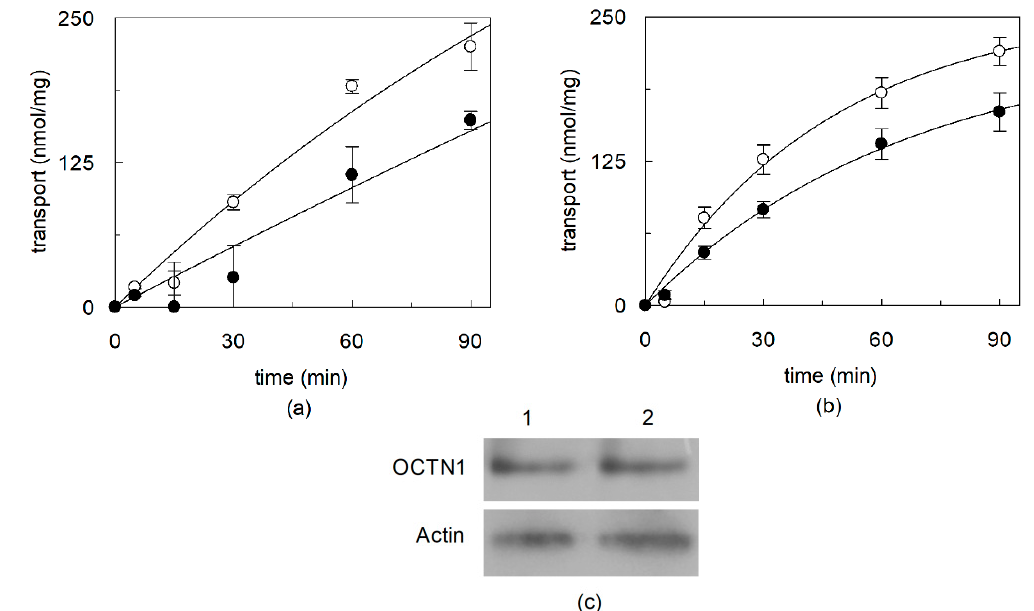
Figure 1. Effect of cholesterol removal on the native OCTN1. (a) HeLa cell protein extract or (b) HeLa cell sample was incubated in the absence ( ○ ) or in the presence of 10 mM M β CD ( ● ) and then the extracts obtained in the two different conditions ( a or b ) and corresponding respectively to 2.1 ± 0.04 ( a ) and 2.2 ± 0.07 µg protein ( b ) were reconstituted in liposomes as described in Section 4.4. Transport was started adding 0.1 mM [ 14 C]-TEA at time zero to proteoliposomes and stopped at the indicated times as described in Section 4.7. Time course data were interpolated in a first order rate equation. The values are means ± SD from three different experiments. (c) Immunodetected OCTN1 from HeLa cells incubated in the absence (lane 1) or in the presence (lane 2) of M β CD. Actin is shown as a control of total lysate loading. OCTN1 or Actin was immunodetected by anti-OCTN1 or anti-Actin antibody, respectively, as described in Section 4.9.